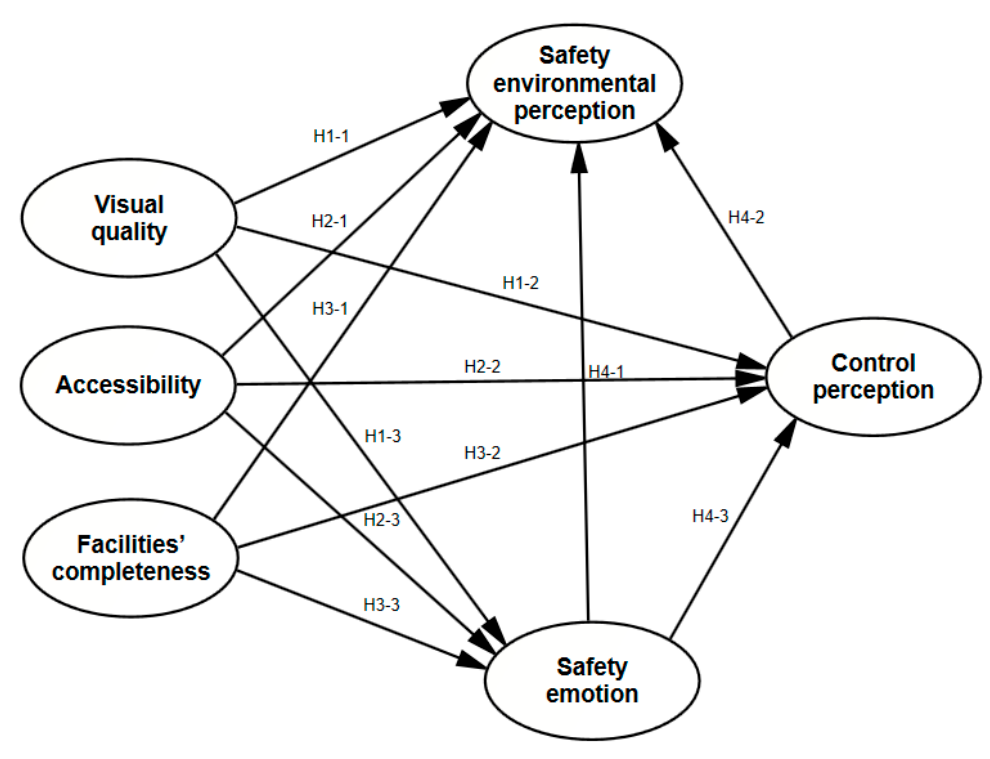
Figure 2. Structural equation modeling (SEM) diagram.